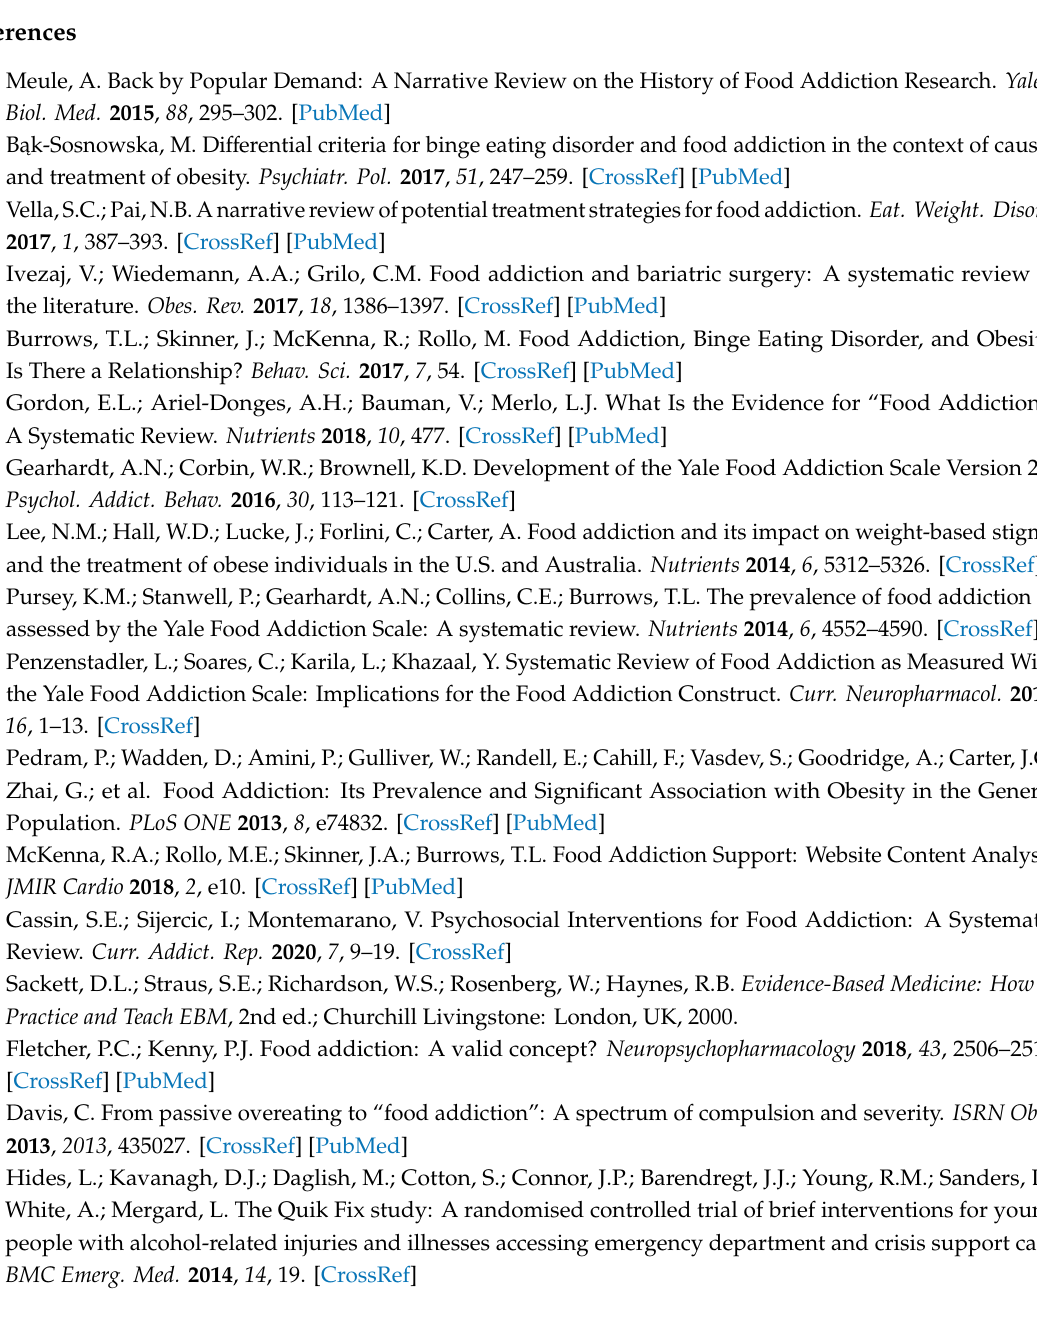
Table S1: Description of the FoodFix intervention